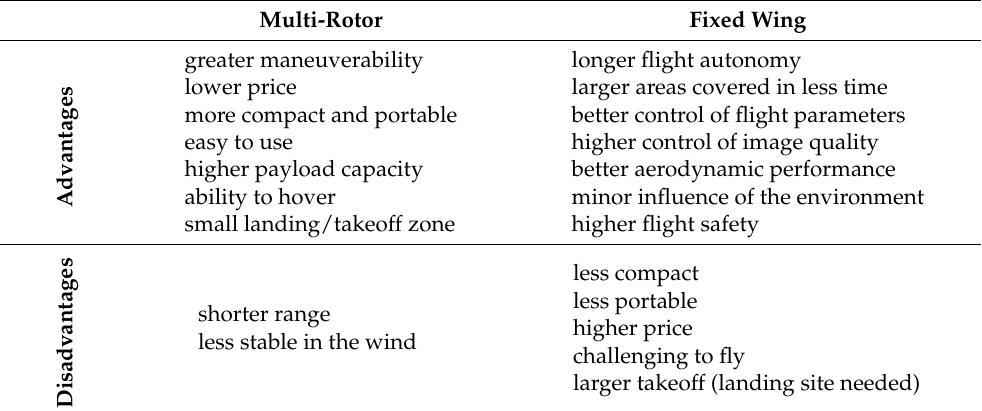
Table 3. Differences between fixed wing and multi-rotor UAVs, after